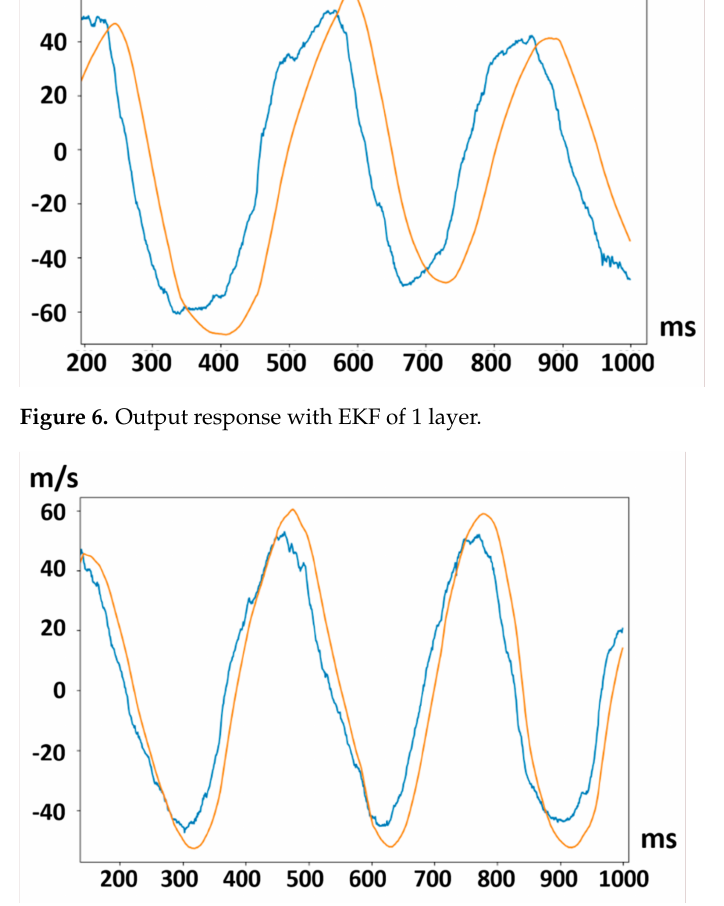
Figure 7. Output response with EKF of 3